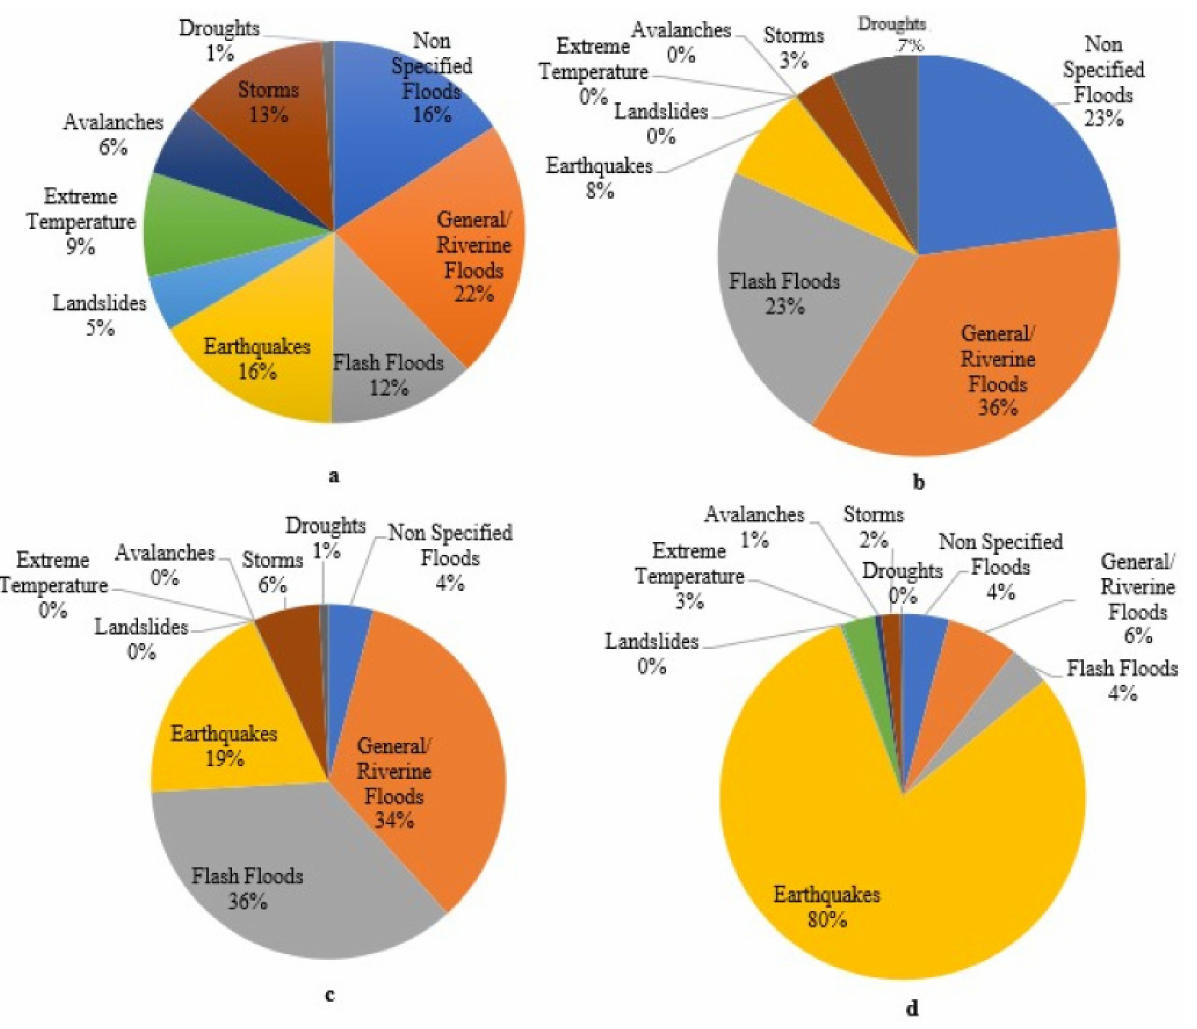
Figure 4. ( a ) Proportion of hazards number b/w 1970–2020 (total 191 events); ( b ) proportion of affected population by hazard type, 1970–2020 (total for 96.77 million people); ( c ) proportion of economic damages by hazard type, 1970–2020 (total of USD 28.45 billion); ( d ) proportion of fatalities by hazard type, 1970–2020 (total no. of fatalities: 99,367) (modified based on EM-DAT,